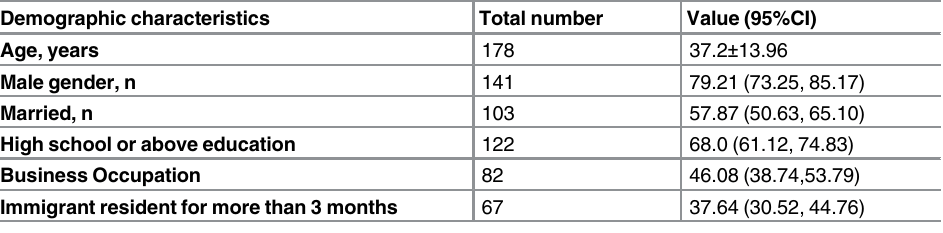
Table 2. Demographic characteristics of patients diagnosed with